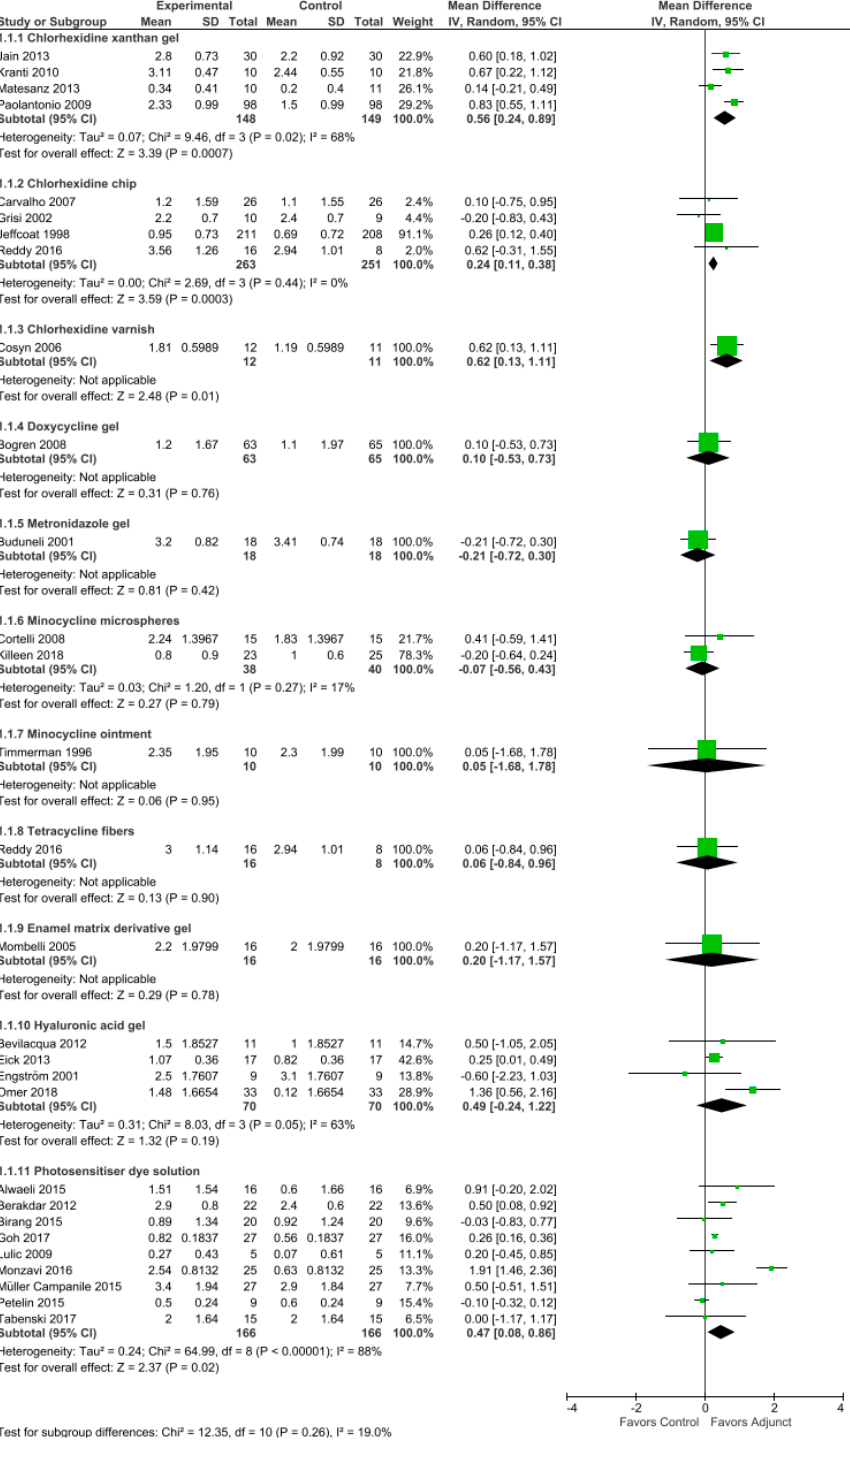
Figure 3. Meta-analysis of studies on changes in probing pocket depth (PPD) for control (mechanical debridement alone) versus use of adjuncts, sub-grouped by agent, based on random effects model; mean difference in units of millimeters.